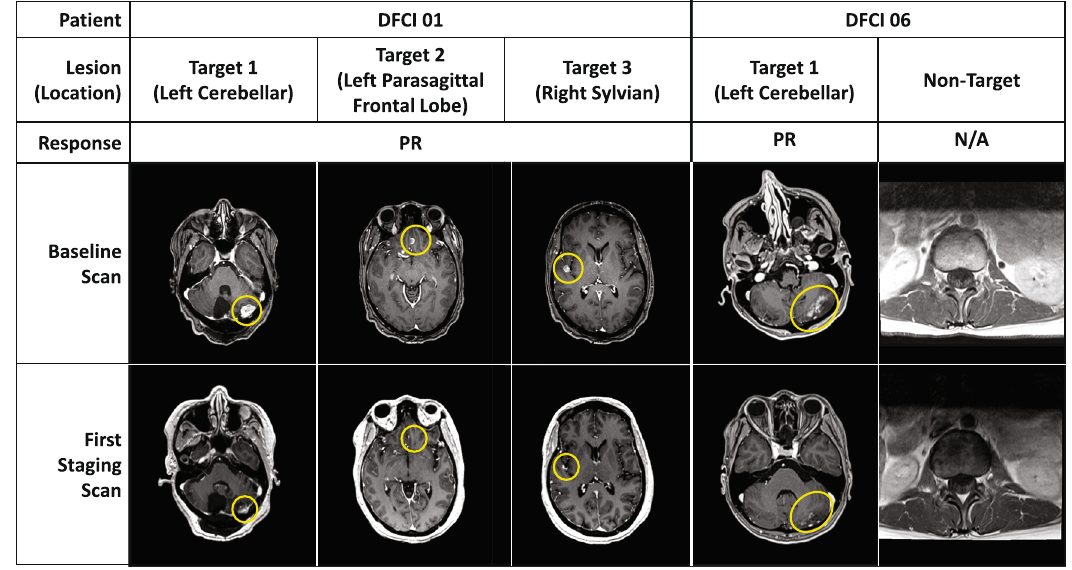
Fig. 3 Radiographic responses to progressive HER2 + LM treated with T-DXd. Baseline and LM response assessment by MRI Brain imaging of two patients with HER2 + LM treated with T-DXd. Encircled are unirradiated CNS lesions highlighting